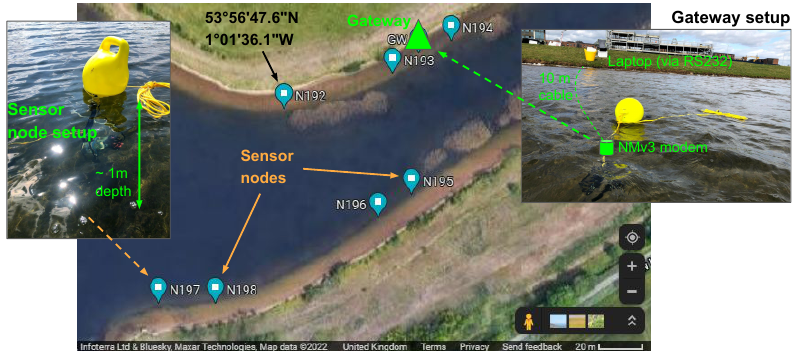
Figure 11. Heslington East lake experiment setup. The nodes were deployed near the shore at shallow depths (1 m depth, with the modem at 0.5 m) on different sides of the lake, with a large amount of vegetation in the middle, resulting in challenging UWA propagation